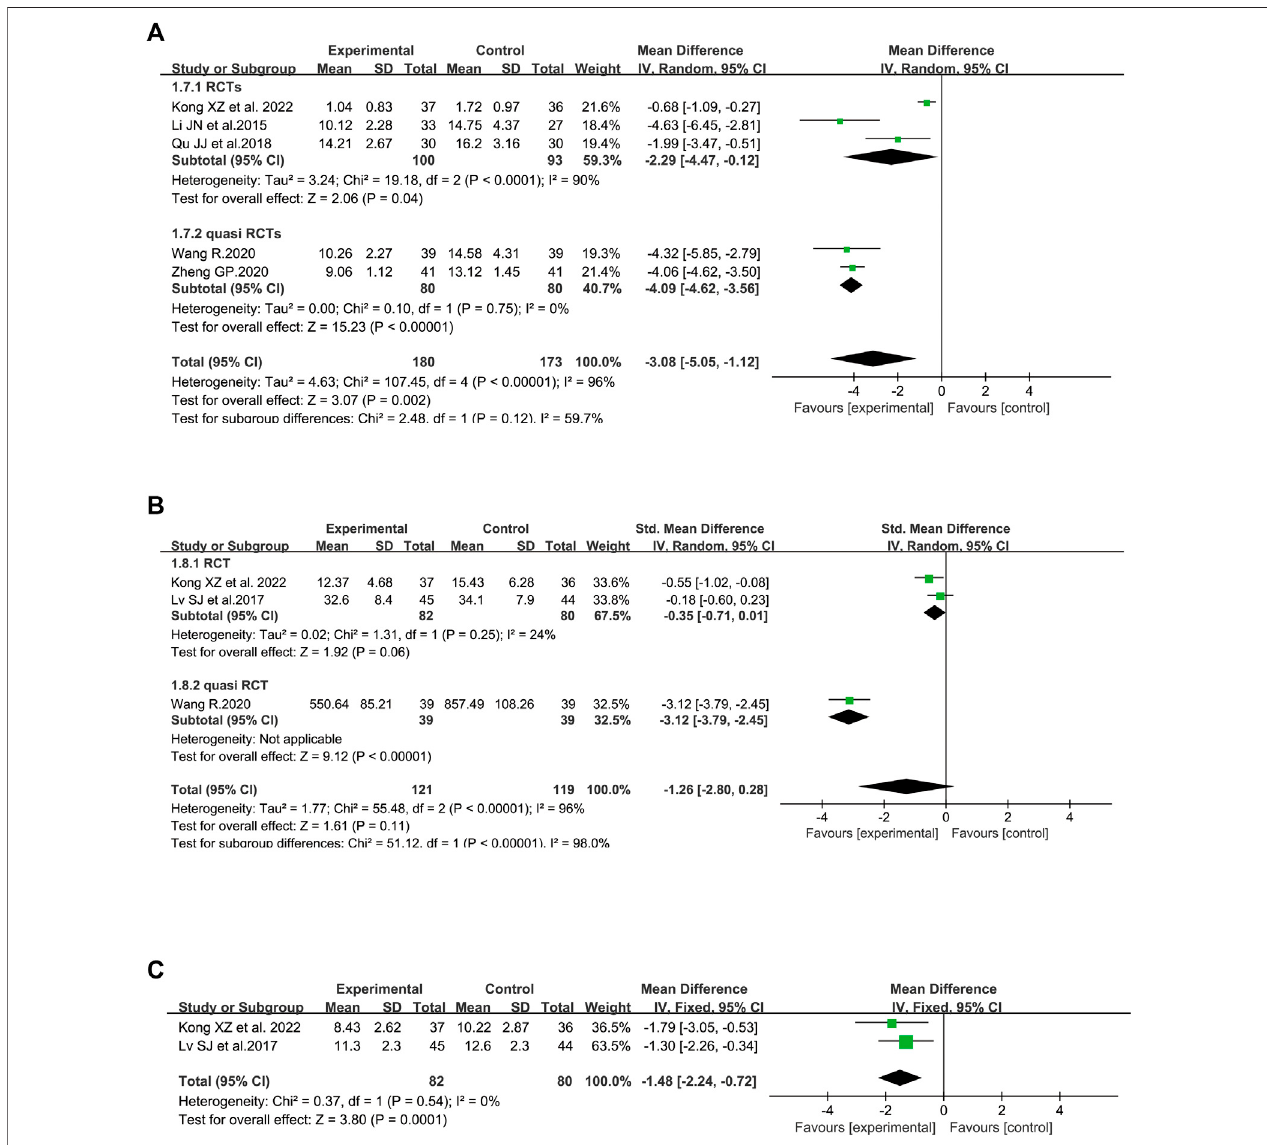
FIGURE 5 | Meta-analysis results of in fl ammatory markers based on: (A) procalcitonin (PCT); (B) C-reactive protein (CRP); (C) white blood cell (WBC) counts.